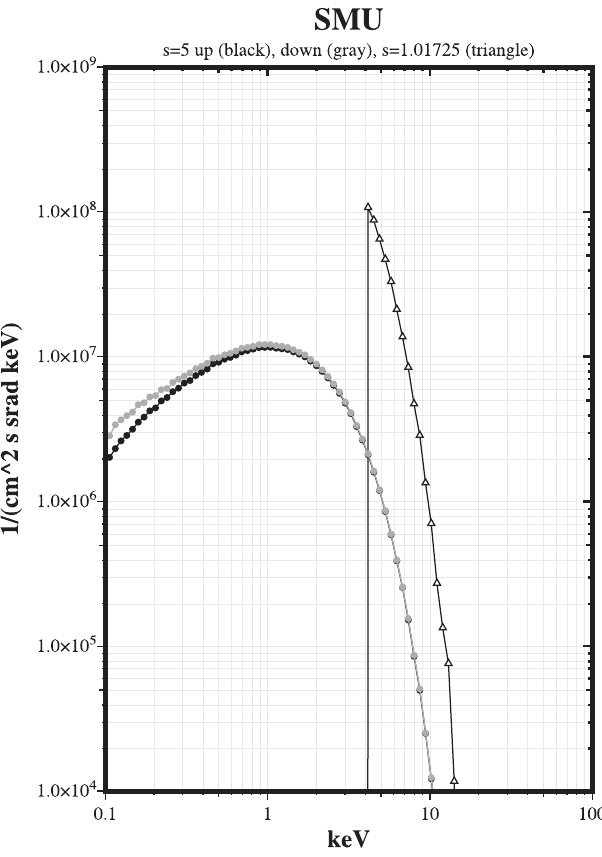
Fig. 5. SMO: single-Maxwellian source plasma and an O-shaped potential. Low-energy electrons are filtered out by the potential barrier and the high energy electrons retain their original flux. The precipitating flux is